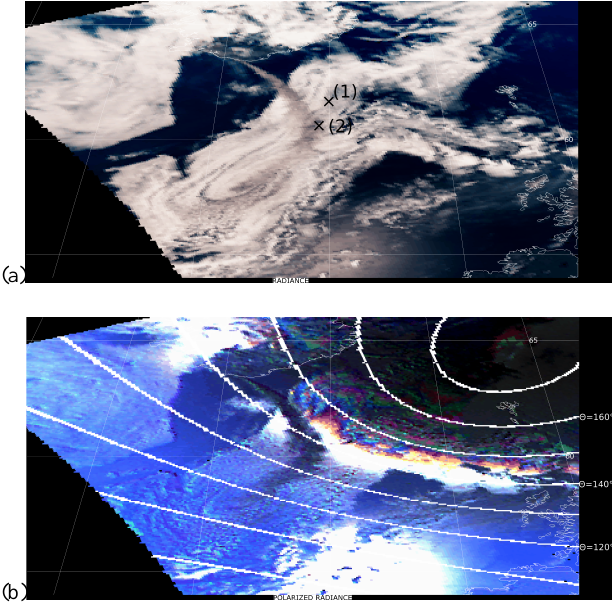
Fig. 5. RGB composites of POLDER measurements (a) in total ra- diance and (b) in polarized radiances. These images were produced using a combination of the POLDER spectral bands centered on 0.490µm, 0.670µm and 0.865µm. These measurements are relative to the PARASOL overpass on 8 May 2010. The polarized radiances measured over the regions (1) and (2), indicated by crosses in (a) , are shown in Fig. 6a. The aerosol properties retrieved over region (2) are reported in Table 2. In (b) , the white circular lines are iso curves (lines of equal value) of scattering